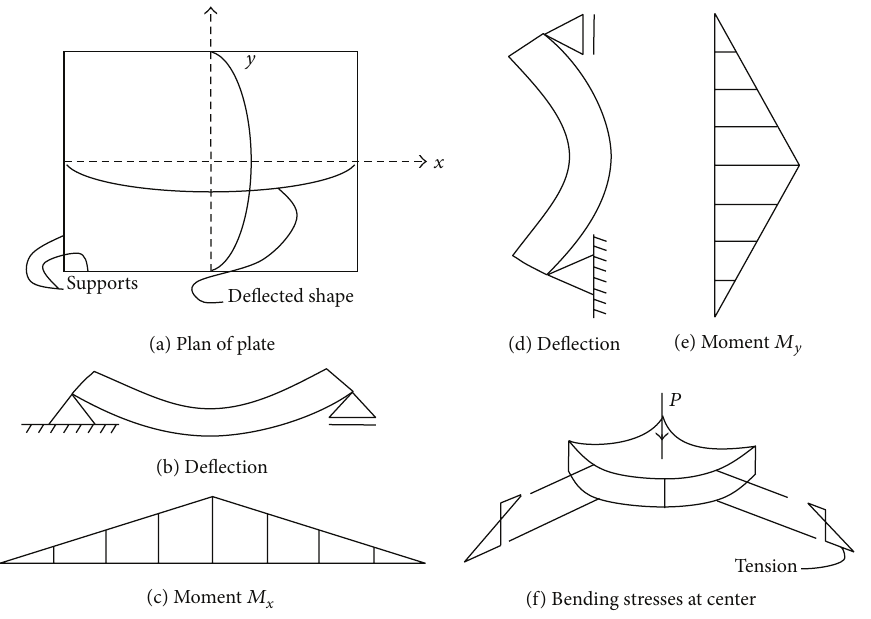
Figure 4: Simply supported flat plate under vertical point loading.